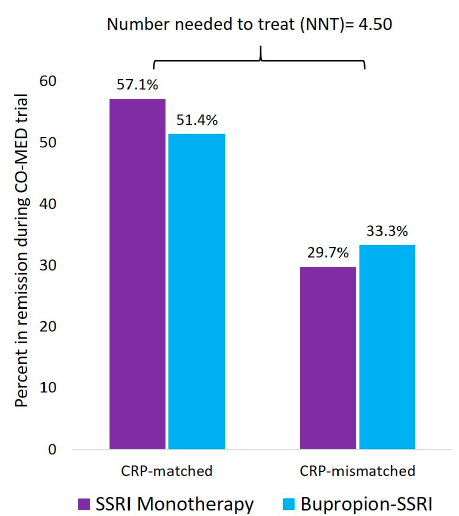
Figure 1. Superiority of CRP-matched treatment assignment to SSRI monotherapy of combination of bupropion and SSRI. CRP is c-reactive protein, CO-MED is Combining Medications to Enhance Depression Outcomes, SSRI is selective serotonin reuptake inhibitor. This figure is based on the findings reported by Jha et al. [92]. CRP-matched treatment assignment refers to participants who received escitalopram only and had CRP < 1 mg/L received escitalopram whereas those with CRP ≥ 1 mg/L received bupropion-SSRI combination. The rest of the participants were grouped in the CRP-mismatched category. The NNT was obtained by subtracting the remission rate in the CRP-mismatched assignment (30.9%) from the remission rate in the CRP-matched assignment (53.1%) and dividing the aforementioned difference by 100.